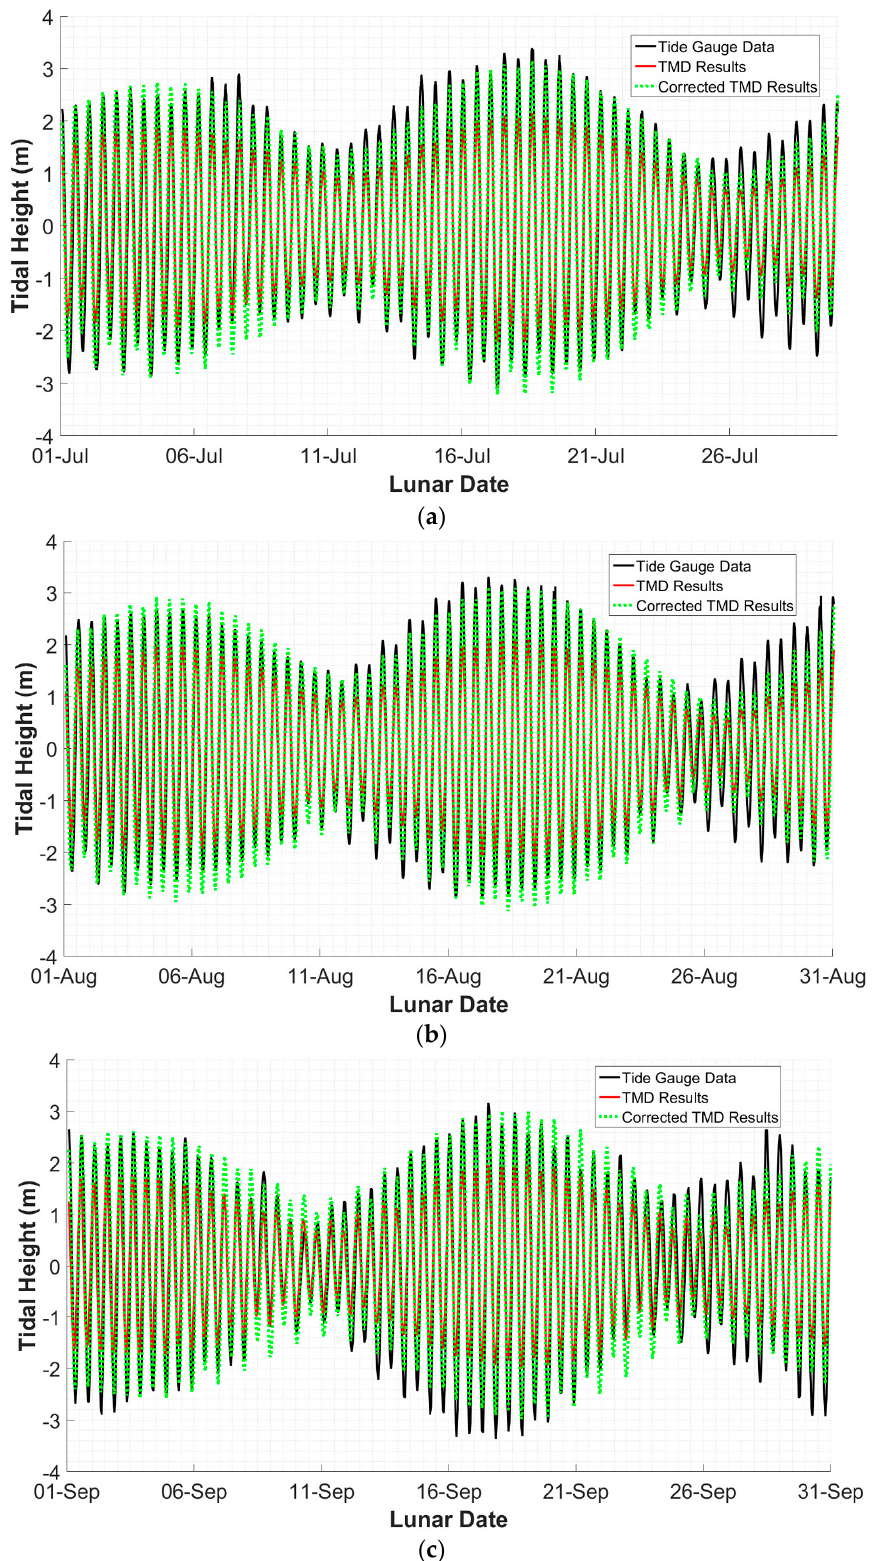
contours are water depth (m). The cross sections A and B (yellow lines, also shown as black lines in Figure 1b) are perpendicular to the paralleled bright stripes on SAR images.